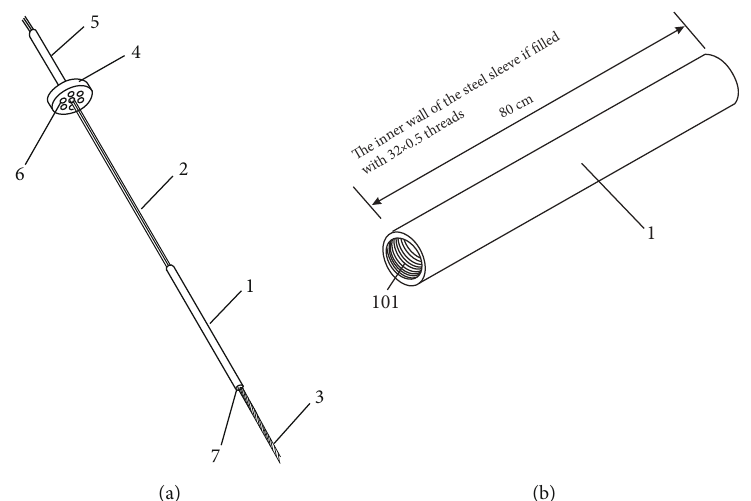
Figure 2: The illustration of the pressure-type BFRP anchor cable: (a) the single bunch of the large-tonnage BFRP anchor cable and (b) the inner wall of the steel sleeve fi lled with threads. Table 2: Strength test of the “ BFRP-connector-strand. ” Steel strand structure for the “ BFRP-connector-strand ” Normal steel strand Quartz sand-coated steel